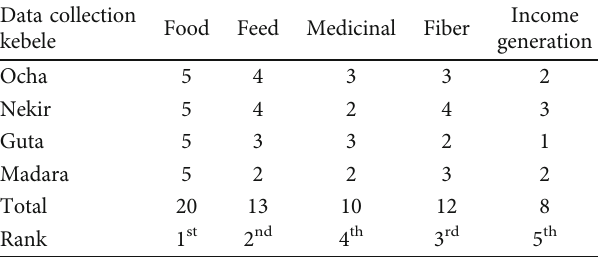
Table 9: Preference ranking for the use-value of